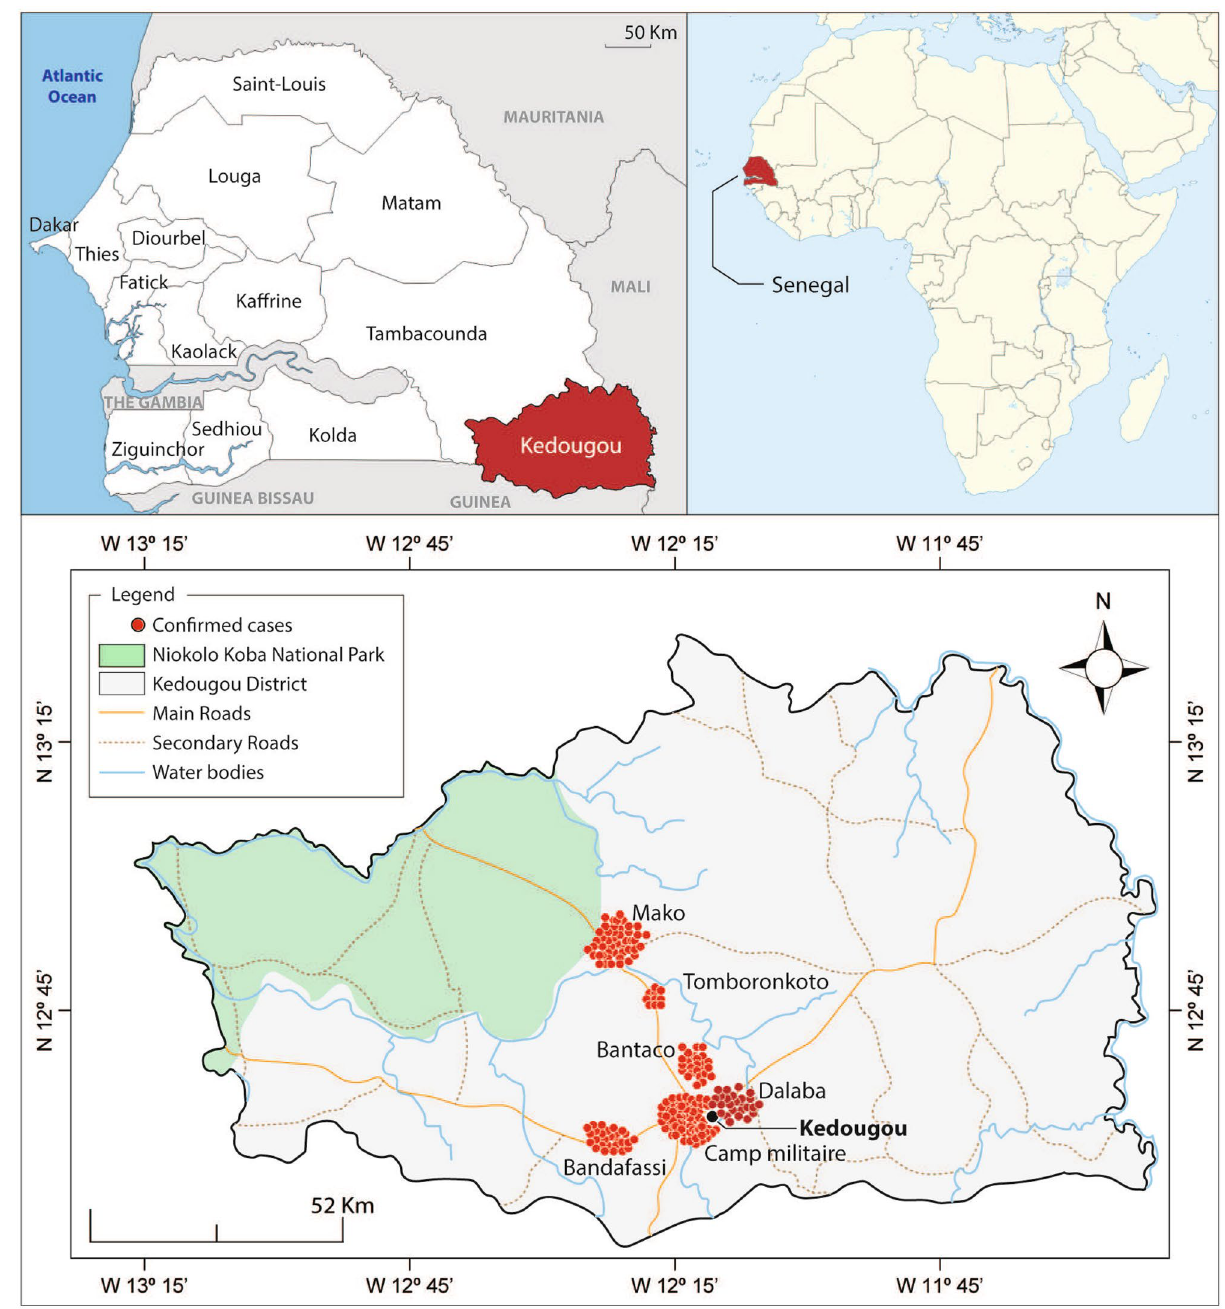
Figure 1. Map of the Study Population: diverse malaria epidemiology within Kédougou Top panel:Kédougou is a region in the South East of Senegal with season malaria transmission from June to December. Bottom panel: The the six sites of enrollment in the present study: Bandafassi, Bantaco, Camp Militaire, Dalaba, Mako, and Tomboronkoto. Each site has a unique epidemiology ranging from rural village (Bandafassi), to mining proximal (Bantaco), to peri-urban (Mako, Tomboronkoto, Dalaba, Camp Militaire). Maps were created with ArcGIS Desktop v10.8.1. (ESRI 2021, Redlands CA; https:// deskt op. arcgis. com/ en/). Red dots represent individual samples enrolled at each site and mapped according to the GPS coordinates of the